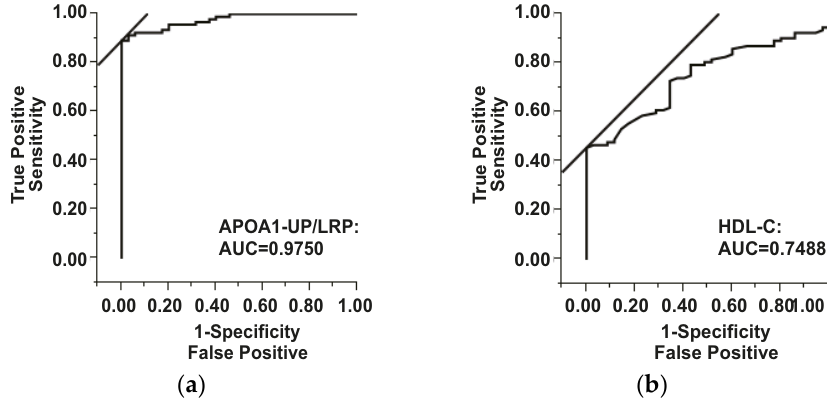
Figure 1. Serum APOA1-UP level and HDL-C level as diagnostic biomarkers for ischemic stroke. Receiver operator characteristic (ROC) curve demonstrating sensitivity as a function of 1-specificity to confirm the diagnosis of ischemic stroke by APOA1-UP/LRP ratio ( a ) or HDL-C level ( b ). APOA1-UP, apolipoprotein A1 unique peptide; LRP, labeled reference peptide; HDL-C, high-density lipoprotein cholesterol; AUC, area under the curve.